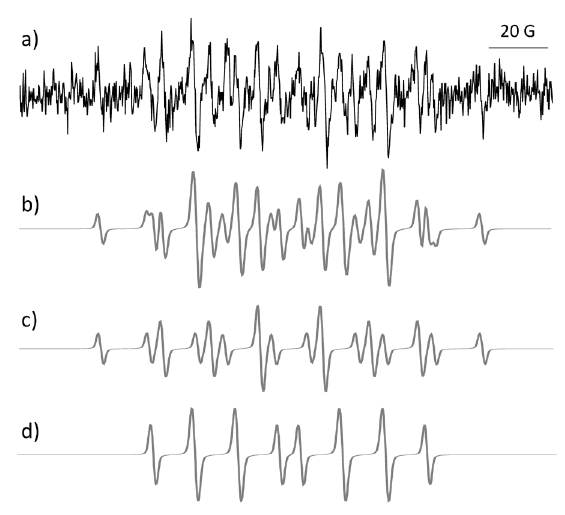
Figure 1: a) EPR spectrum of a water sample containing 50 mM DEPMPO irradiated with plasma for 9 min, power 1.6 W. b) Simulation